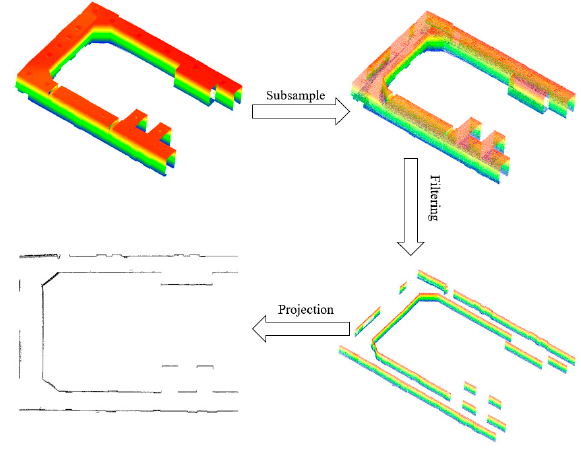
Figure 2. A demonstration of the raw data pre-processing flow. Point cloud is colored in the Z-axis direction.